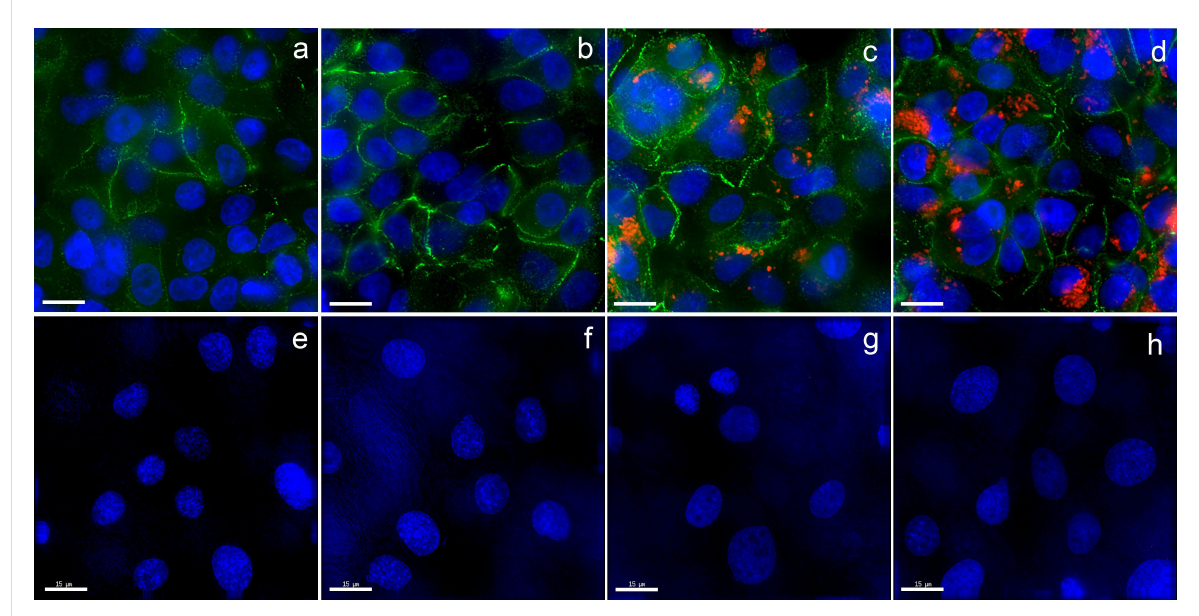
Figure 7: Cellular uptake of aSNP–plain (100 µg/mL, 4 h/20 h) in combination with Alveofact ® (0.04 mg/mL) was examined in the coculture of A549 (A–D) with ISO-HAS-1 (E–H). Green signal: E-cadherin counterstaining of A549 (a–d); red signal: uptake of aSNP–plain, which was apically applied to the A549. A/E: control; B/F: A549 treated with Alveofact ® ; C/G: A549 stimulated with aSNP–plain; D/H: A549 stimulated with aSNP–plain in combi- nation with Alveofact ® . E-cadherin staining of A549 shows an inconsistent pattern, although A549 as well as ISO-HAS-1 formed a confluent mono- layer. No morphological differences could be observed for A549 and ISO-HAS-1 after stimulation with aSNP–plain, Alveofact ® or both. A clear uptake of aSNP–plain was observed with and without Alveofact ® treatment in A549, whereas no visual differences could be identified. No aSNP uptake could be detected in ISO-HAS-1, thus negating a transport of aSNPs through stimulated A549 according to this experimental setup. Pictures are taken by a wide field fluorescence microscope (Applied Precision, DeltaVision), nuclei are stained with Hoechst 33433, scale bar 15